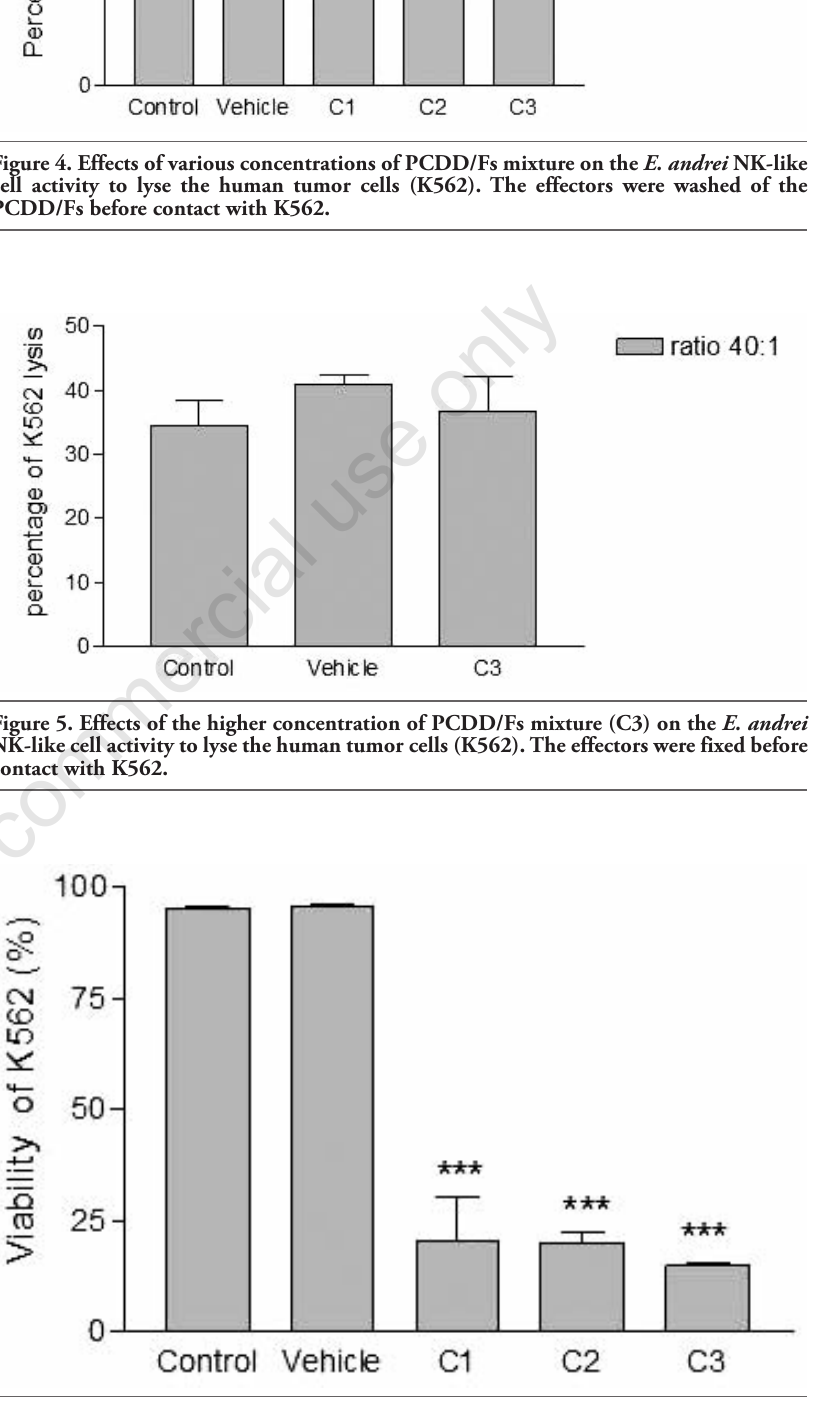
Figure 6. Effects of various concentrations of PCDD/Fs mixture on the human tumor cells (K562) after 3 h of in vitro exposure. Asterisks represent significant difference compared with vehicle controls (***